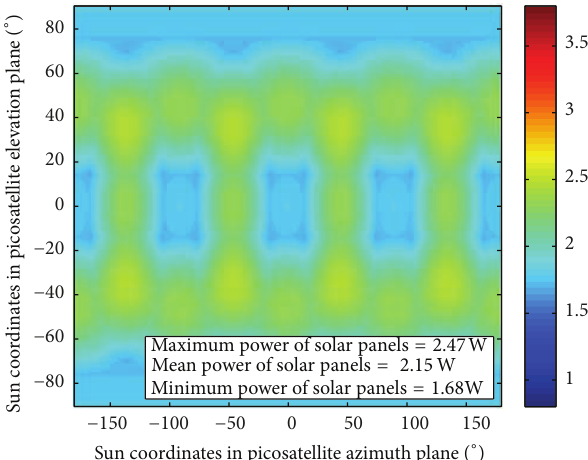
Figure 6: Power generation of gallium arsenide based solar panels placed on CubeSat walls—solar cell temperature 60 ∘ C; angle effi- ciency dependence is also covered in